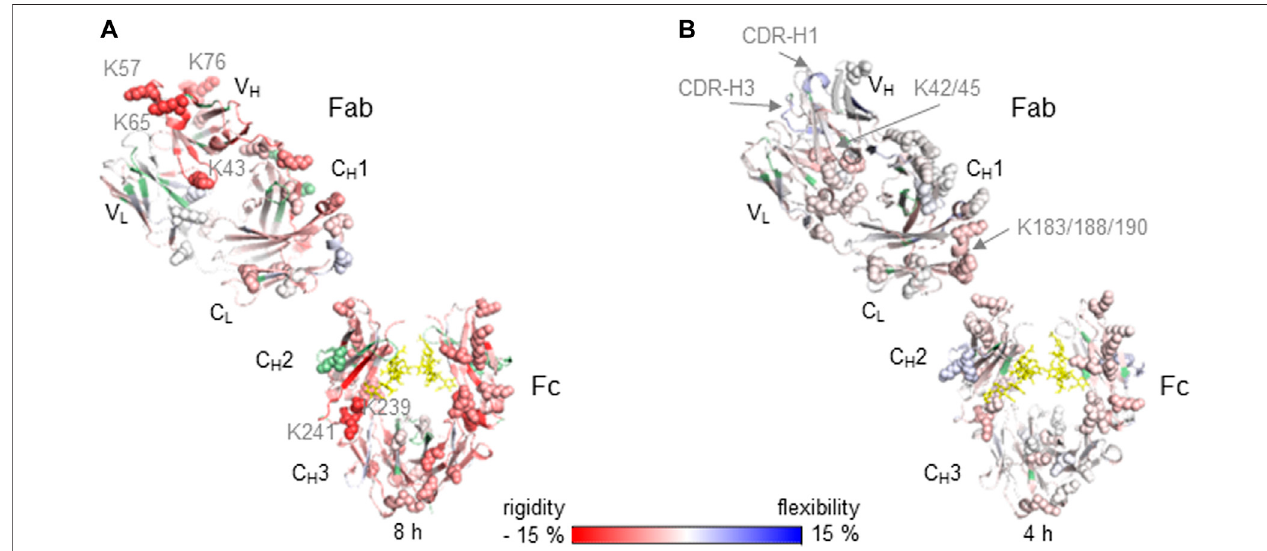
FIGURE 2 | Relative differences in HDX-MS between native (reference state) and lysine conjugated mAb samples are illustrated on the crystal structure for Nivolumab of the generic IgG4 Fc domain (PDB: 4c54) and the Nivolumab speci fi c Fab domain PDB: 5ggq (A) and for Adalimumab on the IgG1 Fc domain (PDB: 5vgp) and Adalimumab speci fi c Fab PDB: 3wd5 (B) . Increased (blue) and decreased (red) HDX-MS rates as relative changes from the native mAbs are indicated by the color bar andareshown forthehighestincubation time8 h (A) and 4 h (B) .Lightchain(LC)domains locatedinFabareV L andC L .Heavychain(HC) domains areV H and